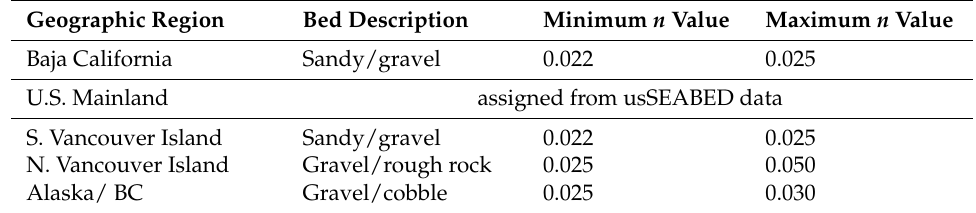
Table 3. Geographic regions used for Manning’s n